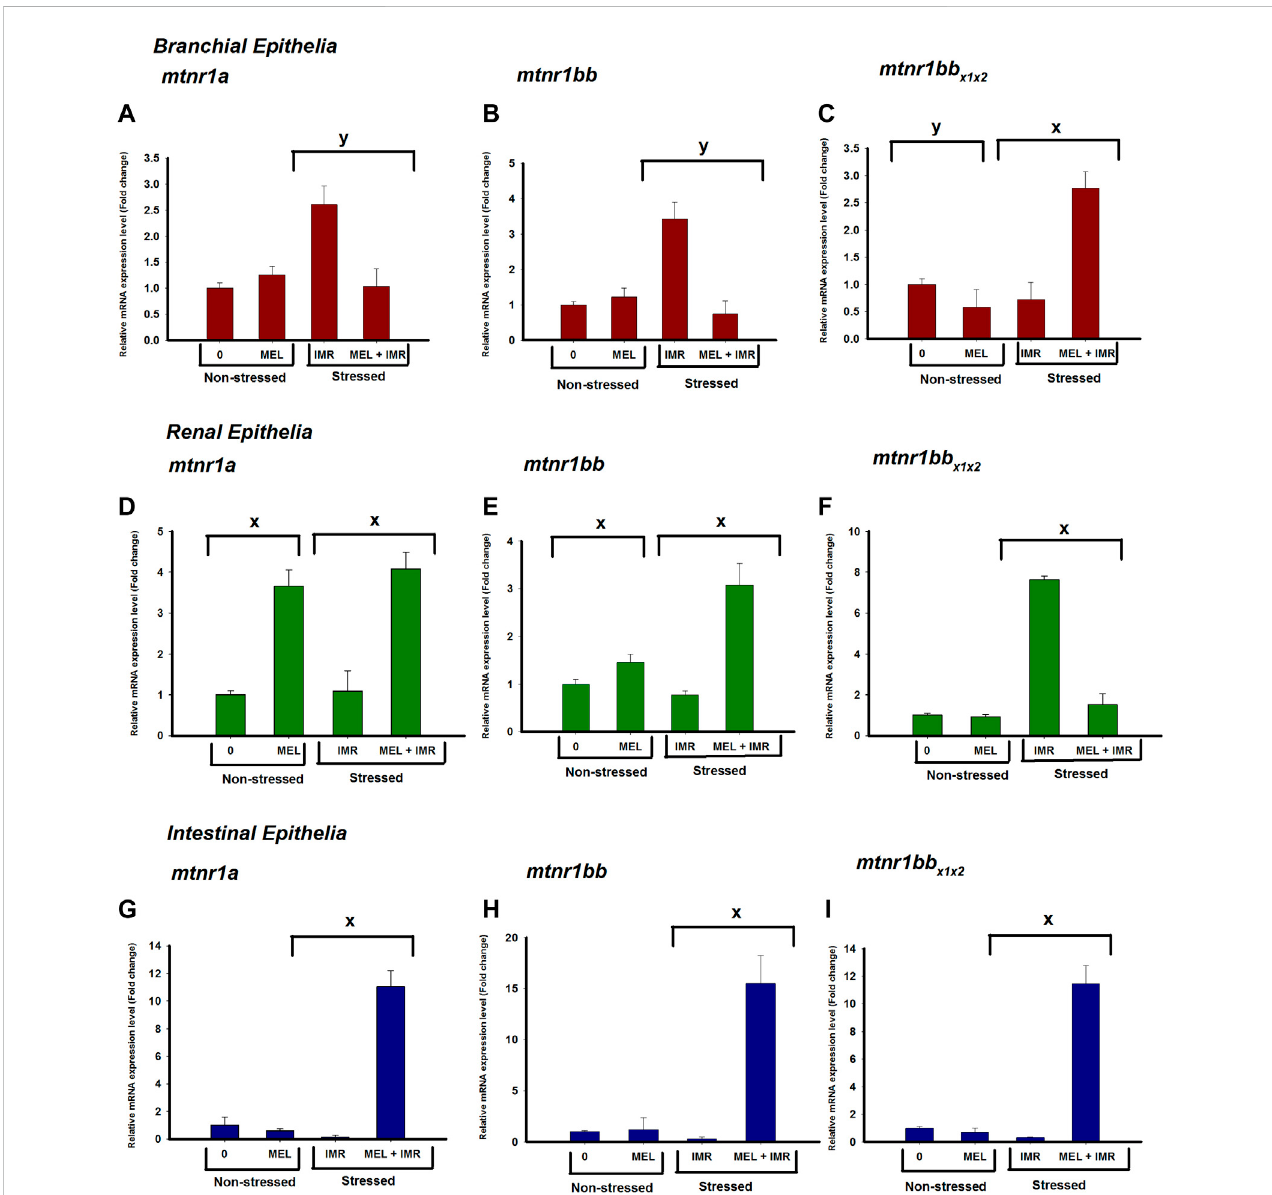
FIGURE 4 RelativemRNAexpressionof mtnr1 subunitisoforms; mtnr1a (A,D,G) , mtnr1bb (B,E,H) and mtnr1bbx1x22 (C,F,I) innon-stressedandimmersion-stressed fi sh after melatonin-treatment(MEL; 50 ng g − 1 )for 30 min 18S rRNA was used as the endogenous control. The data obtained werestatistically analyzed using Relative Expression Software Tool 2009 (REST) and the signi fi cant levels are represented. “ * ” represents signi fi cance between non-stressed control (0) and melatonin(MEL)treatedorcomparisonbetweenIMRandMEL+IMR fi sh. “ # ” denotessigni fi cancebetweennon-stressed control(0)andMEL+IMR fi